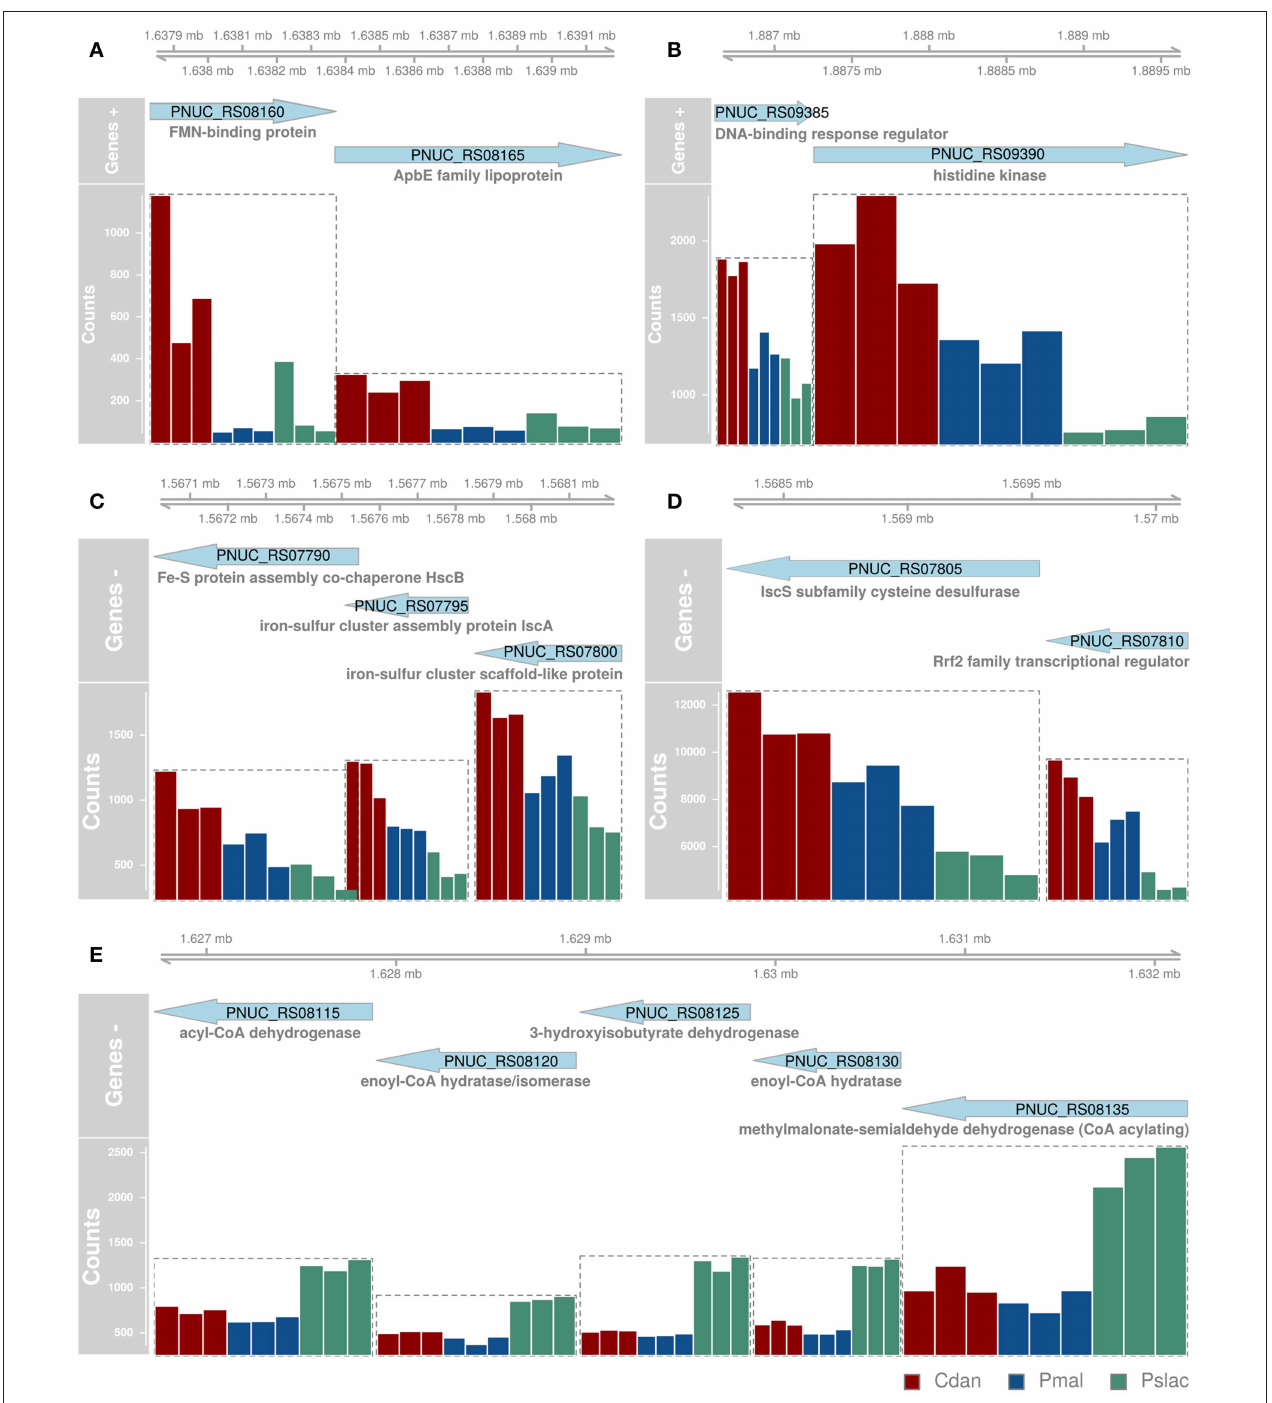
FIGURE 3 | Most significant differentially expressed genes between single-species conditions which are structured in operons. Since many bacterial genes are organized in operons and expressed together, genes which likely belong to the same operon (A-E) are depicted here with their position in the genome (top), orientation (genes +, genes -) and normalized gene counts as bars colored by sample type. Since we did not want to overestimate gene functions of differential genes with similar functions belonging to the same operon, we had to determine the operons prior to functional analyses. All significant differentially expressed genes can be found in Figure S2 and the 20 most differentially expressed genes (independent of operon structure) are also depicted in Figure 4 .